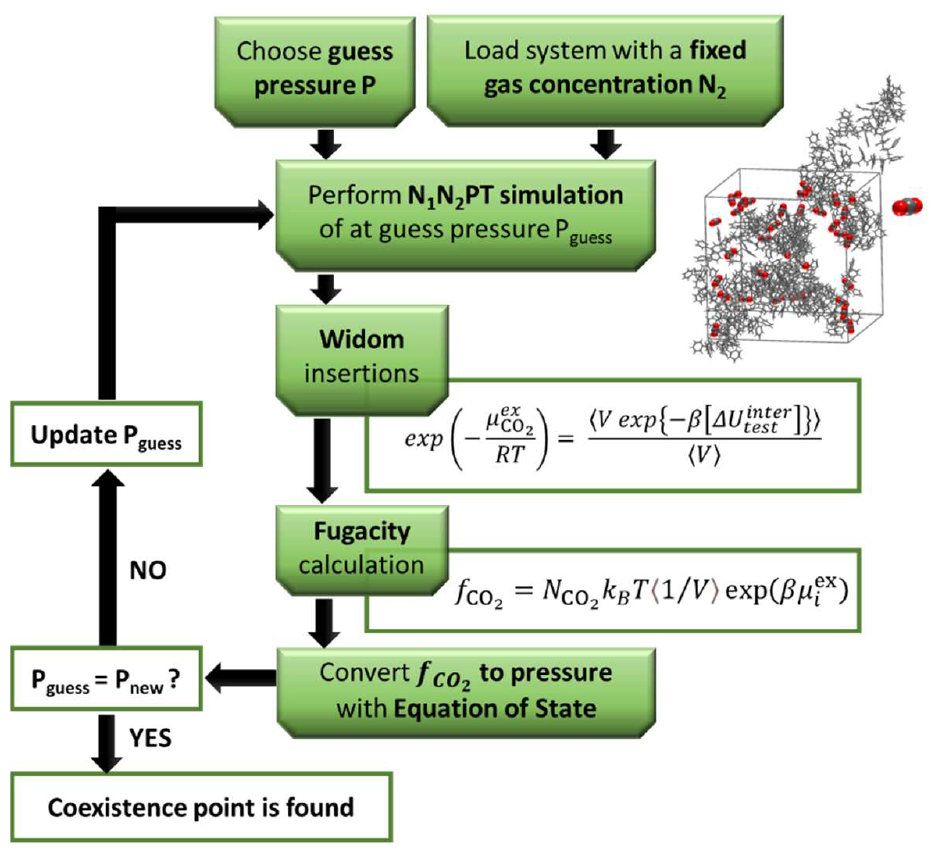
Figure 18. Schematic representation of the iterative NPT /Widom algorithm for molecular simulation of gas solubility in polymers at high pressure.